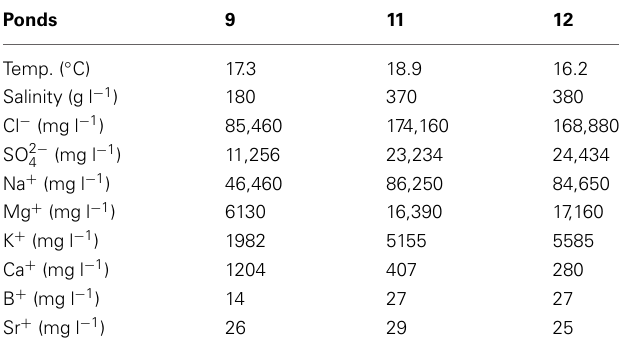
Table 1 | Physicochemical parameters in evaporation